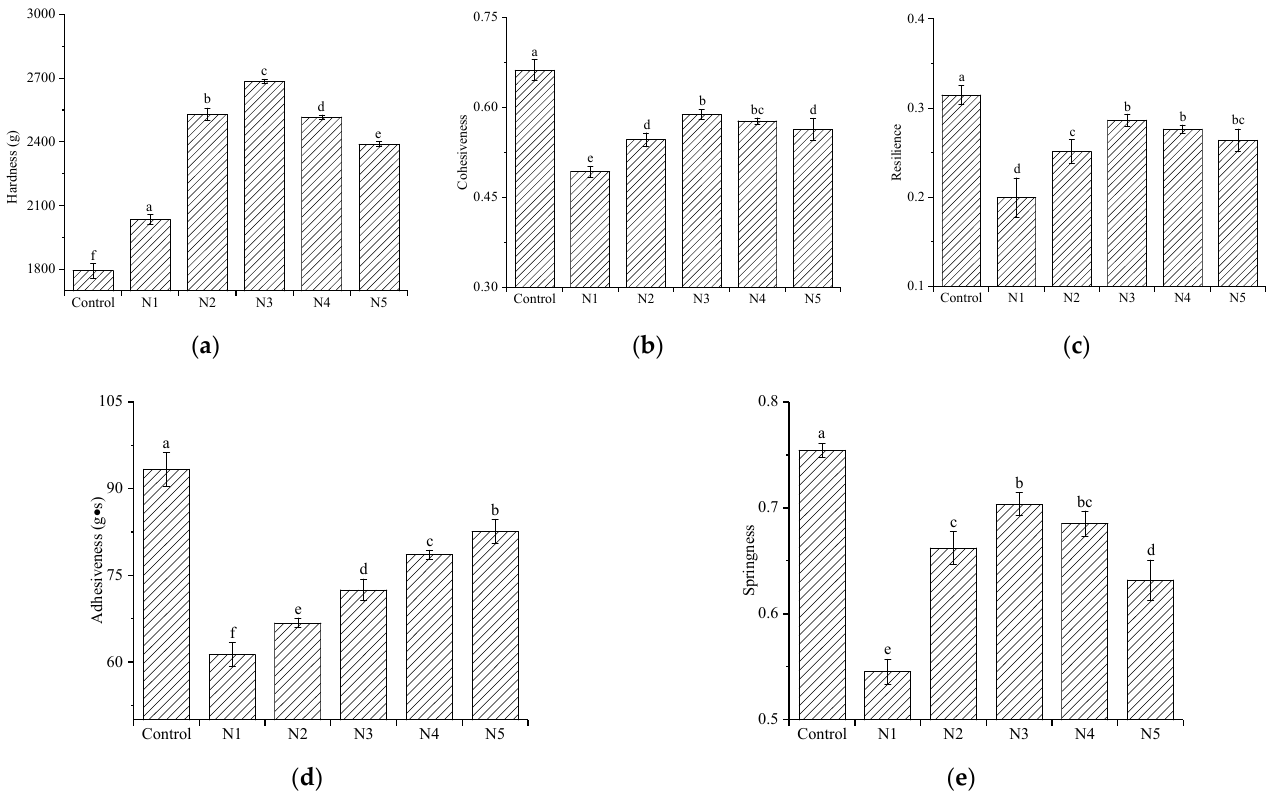
Figure 3. Textural properties of cooked whole-wheat noodles. ( a ) Hardness; ( b ) cohesiveness; ( c ) resilience; ( d ) adhesiveness; ( e ) springiness. Different lowercase letters on columns indicate significantly different values ( p < 0.05). N1, N2, N3, N4, and N5 are noodles corresponding to wheat brans with decreases in particle size sequentially. The noodles made from refined wheat flour served as a control group.